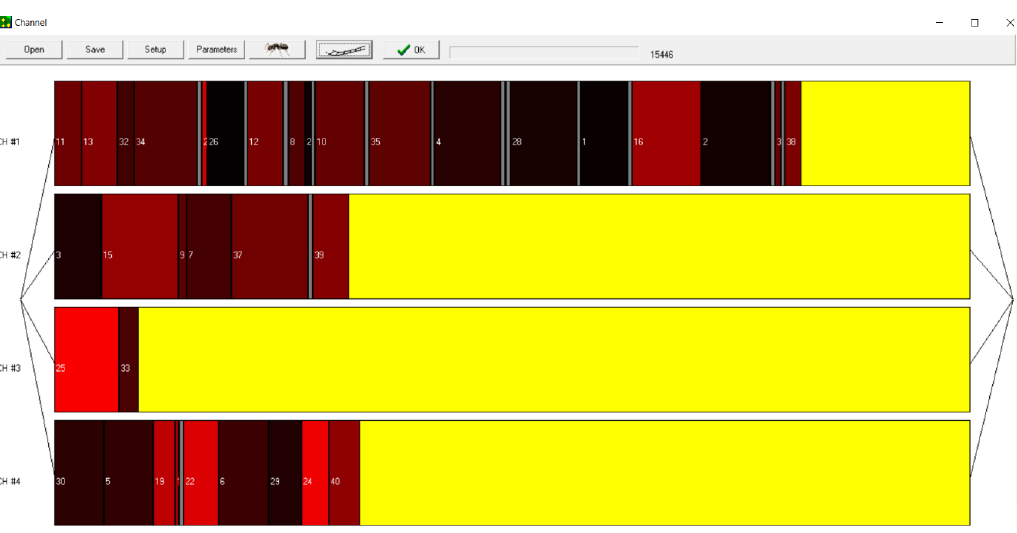
Figure 4. Uniform allocation in case of parameter α = 1. If the cost is considered for the purpose of optimization, the 18,189.75 time units cannot amount to less than 16,273 units of expenditure. The example is examined for the expenditure case in which the parameter of the expenditure (beta) is 1 and the lead time (alpha) is 0 (Figure 5).